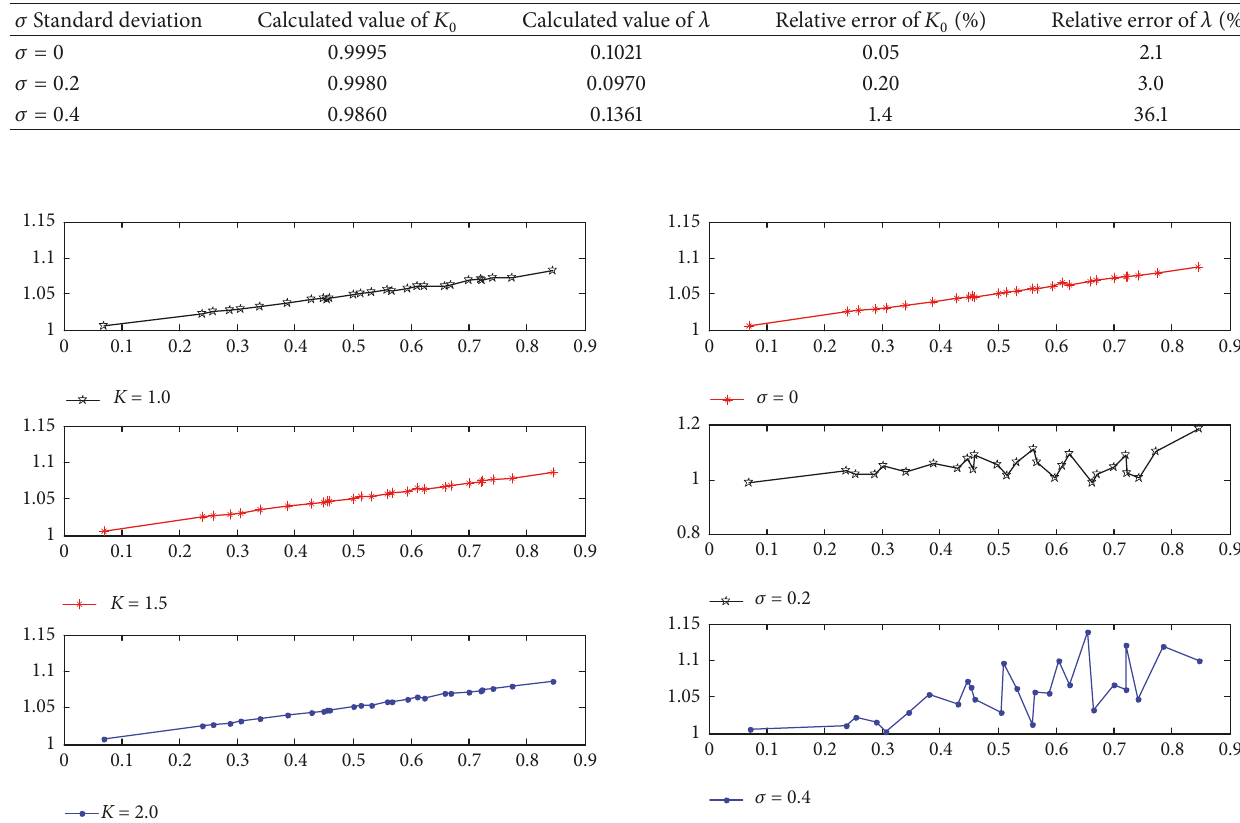
least square method; the average relative errors are shown in Table 4. When 𝜎 = 0 , the average relative errors of 𝐾 0 and 𝜆 are 0.05% and 2.1%; when 𝜎 = 0.2 , the average relative errors of 𝐾 0 and 𝜆 are 0.20% and 3.0%; when 𝜎 = 0.4 , the average relative errors of 𝐾 0 and 𝜆 are 1.40% and 36.1%.